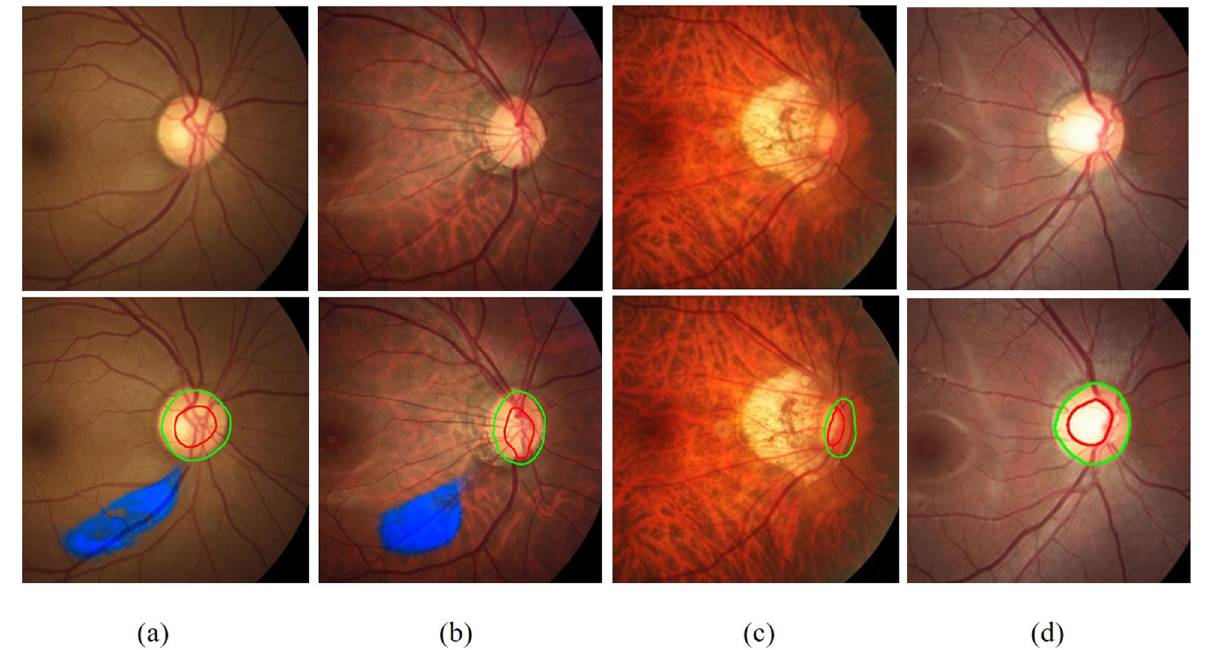
Fig. 6 Examples of fundus images misdiagnosed by junior doctors and technicians. Above: original images; Below: images analyzed by hierarchical deep learning system (HDLS). a Glaucomatous fundus image with insigni fi cant retinal nerve fi ber layer defects (RNFLD). b Glaucomatous fundus image with vascular curvature information indicating localized rim thinning. c Glaucomatous fundus image with high myopia. d Normal fundus image with physiologic large